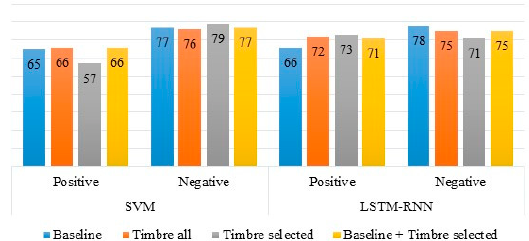
Figure 6. Recognition rates of positive and negative emotions on baseline, timbre all, timbre selected, and the combination of baseline and timbre selected acoustic feature sets for IEMOCAP.